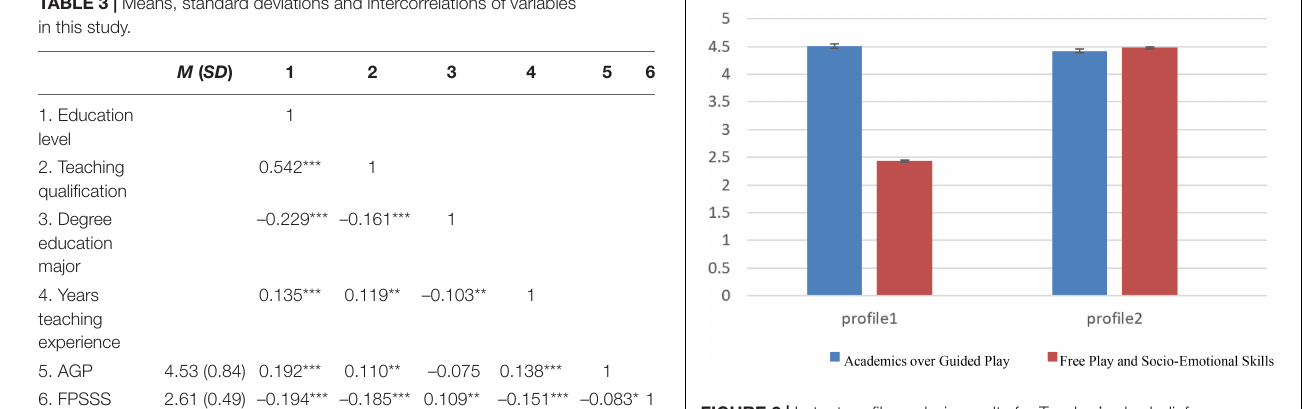
( M = 2.43, SD = 0.02). Profile 2 was distinguished by high scores on both AGP ( M = 4.42, SD = 0.03) and FPSSS ( M =